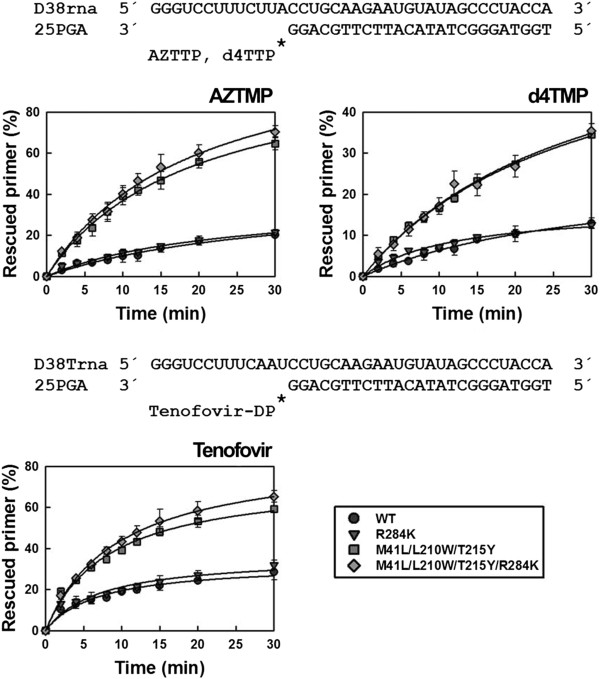
Rescue DNA polymerization initiated from AZTMP-, d4TMP-, and tenofovir-terminated primers annealed to an RNA template. Time course experiments of excision reactions were carried out in the presence of 3.2 mM ATP. The nucleotide sequences of template-primers used are given above their corresponding graphs. All dNTPs in the assays were supplied at 200 μM, except for dATP or dTTP (depending on the reaction) whose concentration was 2 μM. Template-primer and active RT concentrations in these assays were 30 and 24 nM, respectively. The values (averages standard deviations [error bars]) were obtained from three independent experiments.